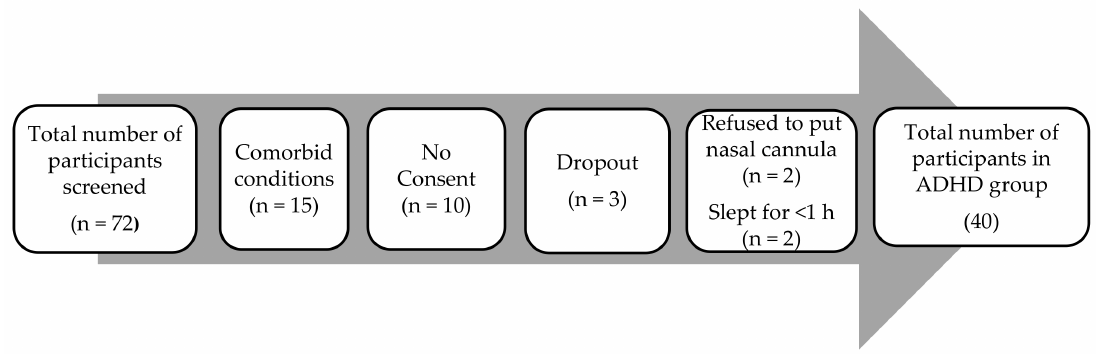
Figure 1. Recruitment process for participants in the ADHD group.